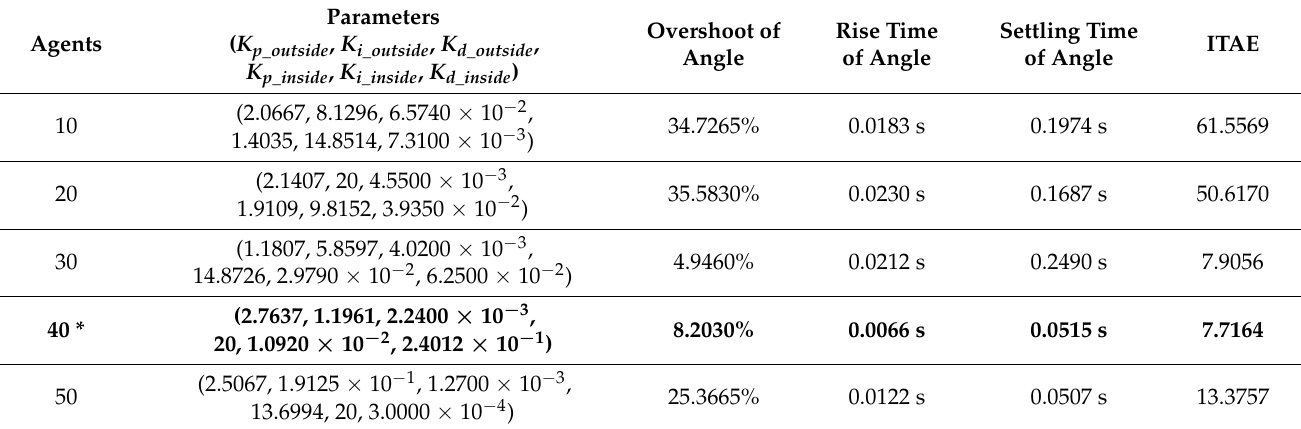
Table 6. Attitude control of balancing robots under PSO-PID